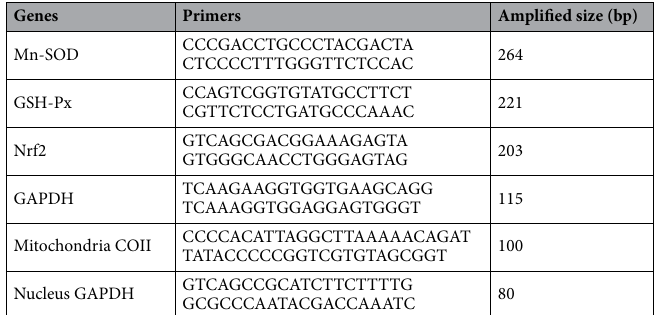
Table 4. List of the primers used in the qRT-PCR